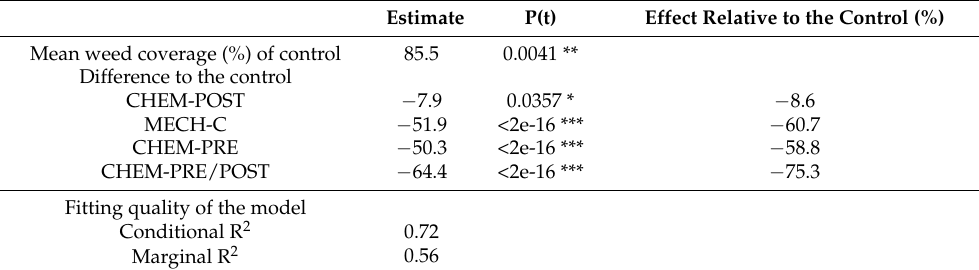
Table 6. Regression: effect of weed control treatments on weed coverage (%). The proportion of the model’s explained variance and significance (F-test). Marginal R 2 provides the variance explained only by fixed effects and conditional R 2 provides the variance explained by the entire model, i.e., both fixed effects and random effects.